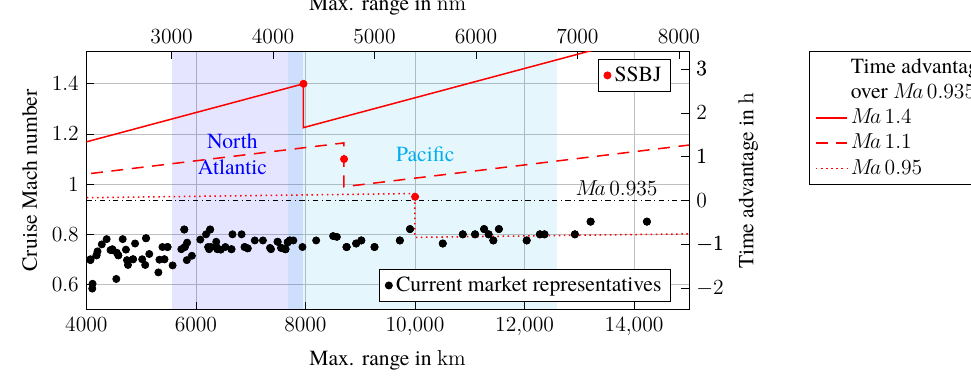
Figure 1. Maximum range and cruise Mach number capabilities of business jets